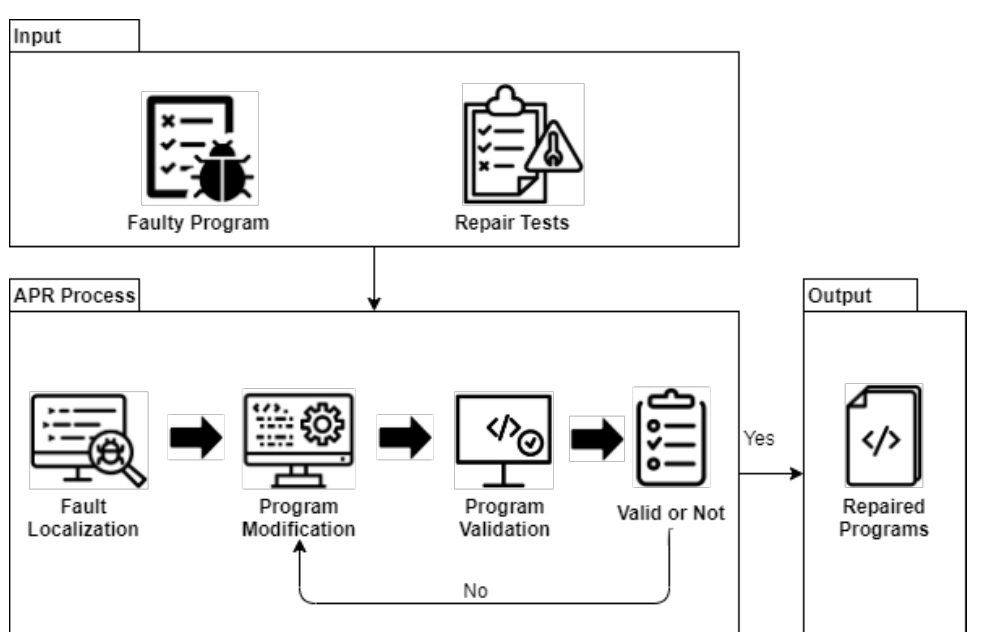
Figure 1. Automatic Program Repair (APR): Generate and Validate